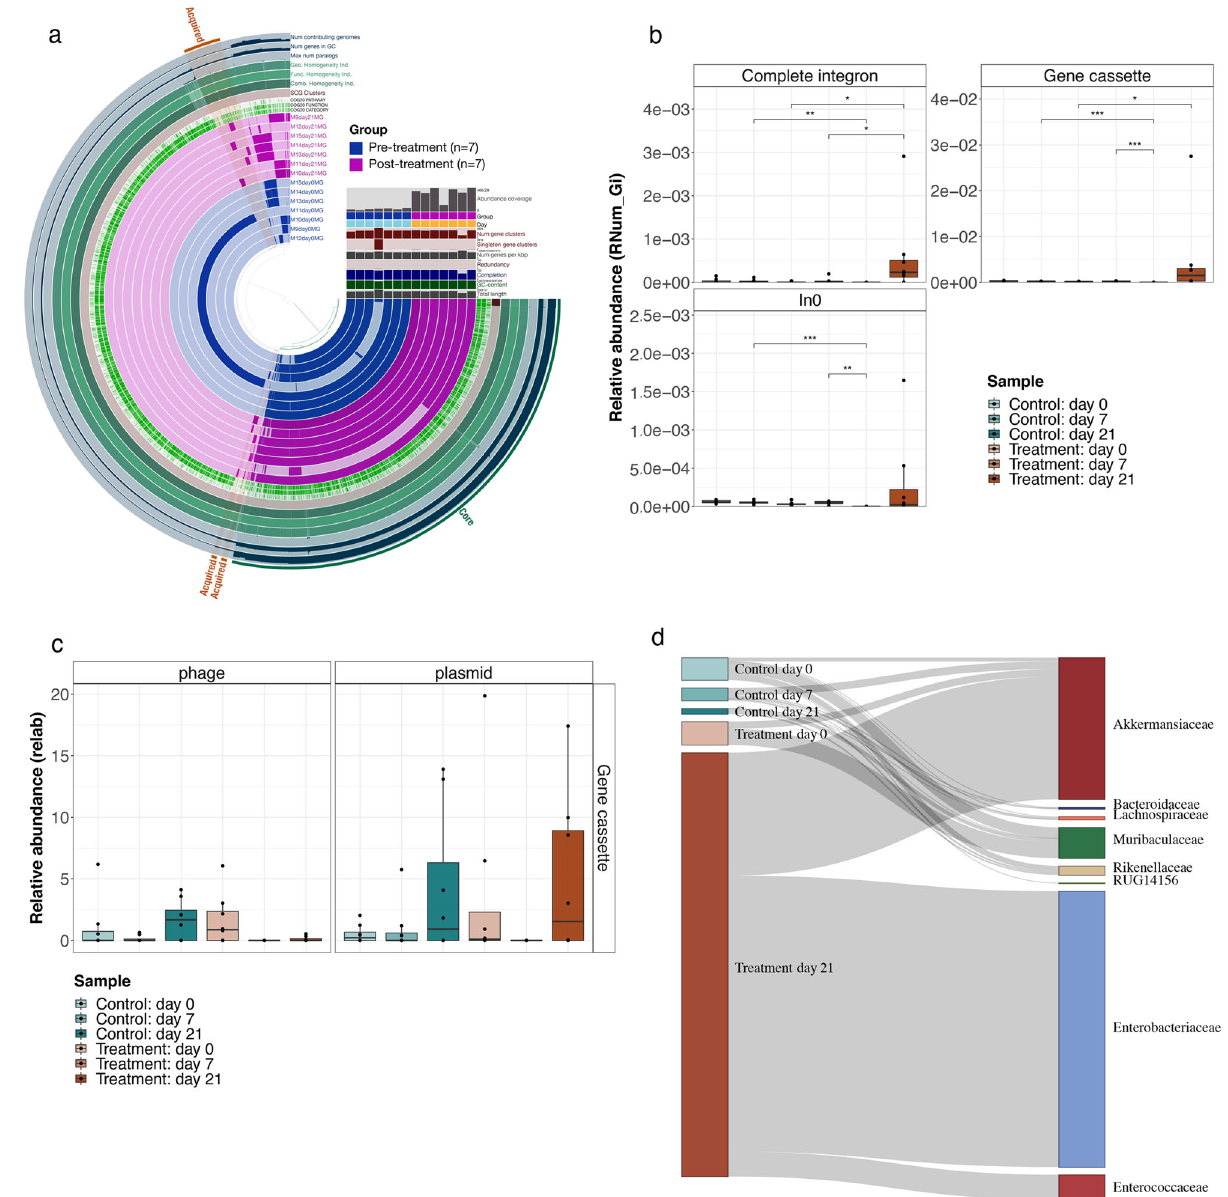
Fig. 4 AMR-mediated via integrons in mice administered with antibiotics. a Anvi ’ o based visualization of the Akkermansia muciniphila genomes from the pre- and post-treatment (day 0 and day 21 respectively) samples in blue and purple respectively. Annotations on the outer ring indicate the ‘ Core ’ genome and the ‘ Acquired ’ genome partially (75%) mediated by integrons. GC: gene clusters; Geo. Homogeneity Ind.: geometric homogeneity index; Func. Homogeneity Ind.: functional homogeneity index; Comb. Homogeneity Ind.: combined homogeneity index. b Boxplots showing the relative abundance of ARGs linked to integrons. n = 8 biological replicates per group. The center line denotes the median value (50th percentile), while the outer lines of the box represent the 25th – 75th percentiles. The black whiskers mark the 5th and 95th percentiles. A two-sided Wilcoxon rank sum test was used to assess signi fi cance, where, p -values are indicated by *, i.e., * < 0.05, ** < 0.01, *** < 0.001. c Relative abundance of gene cassettes found to be encoded by phages and plasmids across different groups ( n = 8 biological replicates) and timepoints. The center line denotes the median value (50th percentile), while the outer lines of the box represent the 25th – 75th percentiles. The black whiskers mark the 5th and 95th percentiles. d Alluvial diagram demonstrating the abundance of ‘ complete ’ integrons linked with observed ARGs in speci fi c taxonomic families. The fl ow (gray) bars indicate the number of AMR-linked integrons found in each group. Source data are provided as a Source Data fi